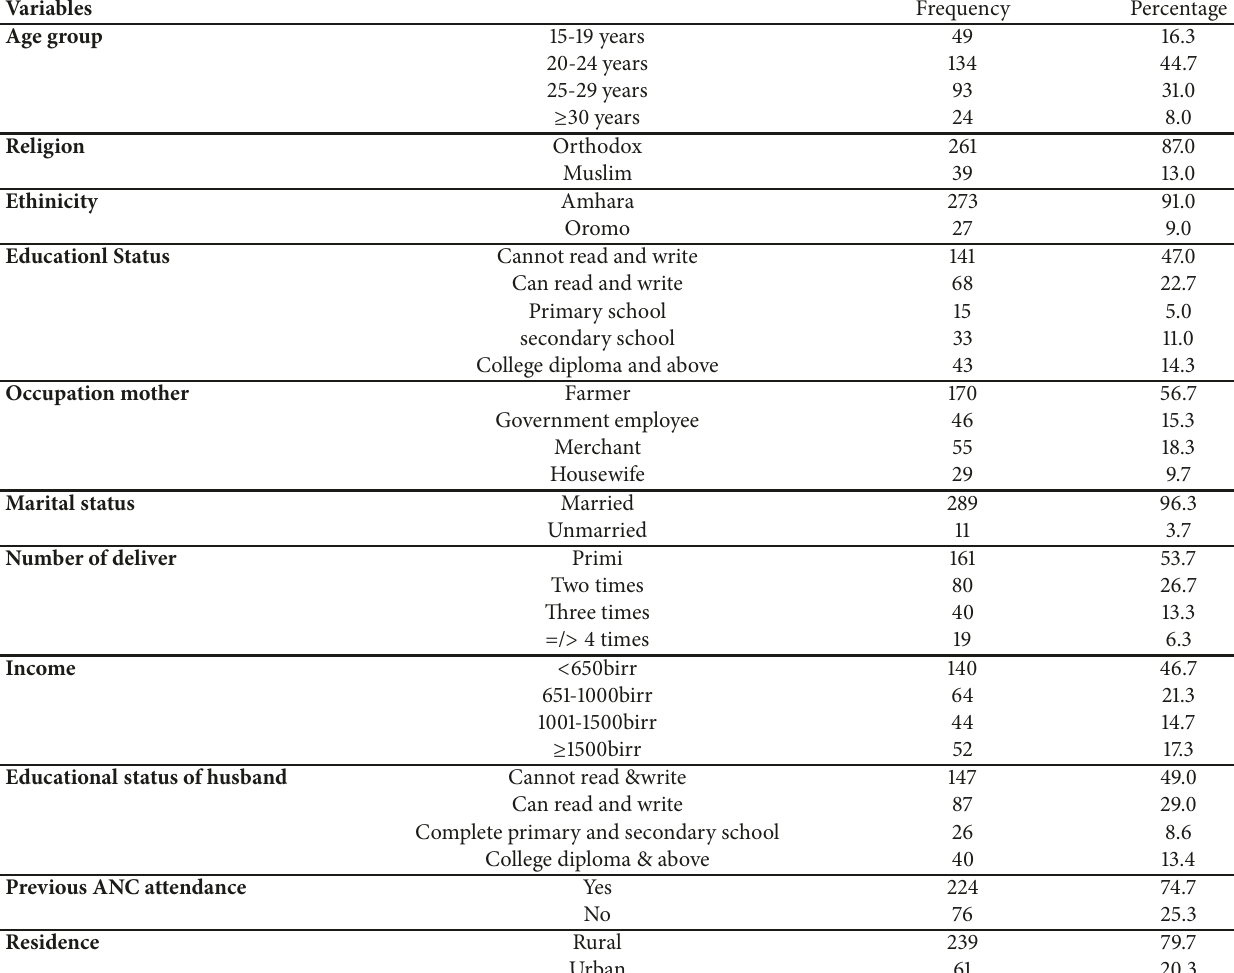
Table 1: Sociodemographic characteristics of ANC follow-up women in Awabel district, Northwest Ethiopia, April 15-May 17, 2016